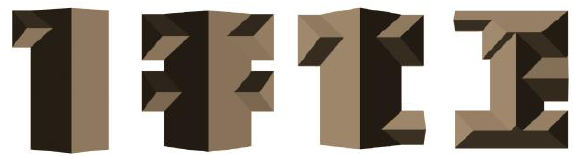
Figure 4. An overview of GAN-based reconstruction of 3D roof models using Roof-GAN with 2,3,4 and 5 primitives (left to right) (Qian et al.,